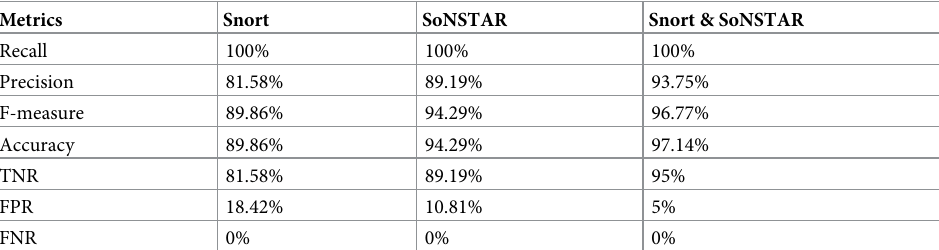
Table 5. Evaluation results.